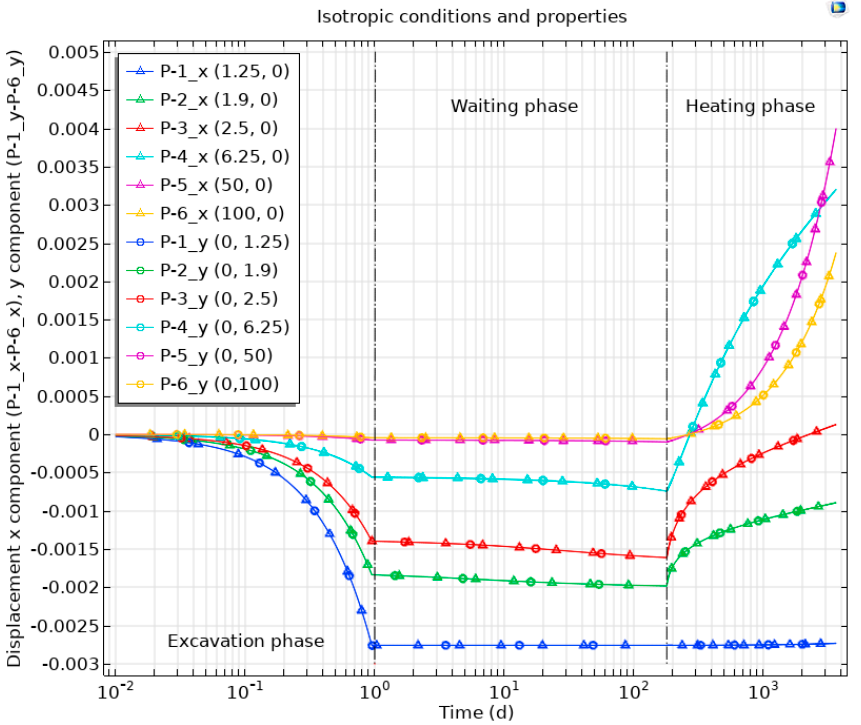
Figure 15. UDC variant: evolution of displacements at selected points under the isotropic stress conditions and isotropic properties.